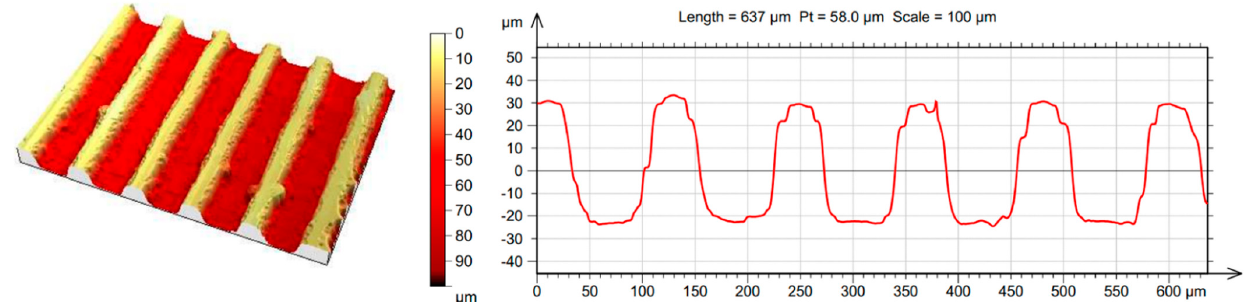
Figure 4. Microscopic view: Test specimen, manufactured with high injection rate (104 cm 3 /s), parallel ribs.